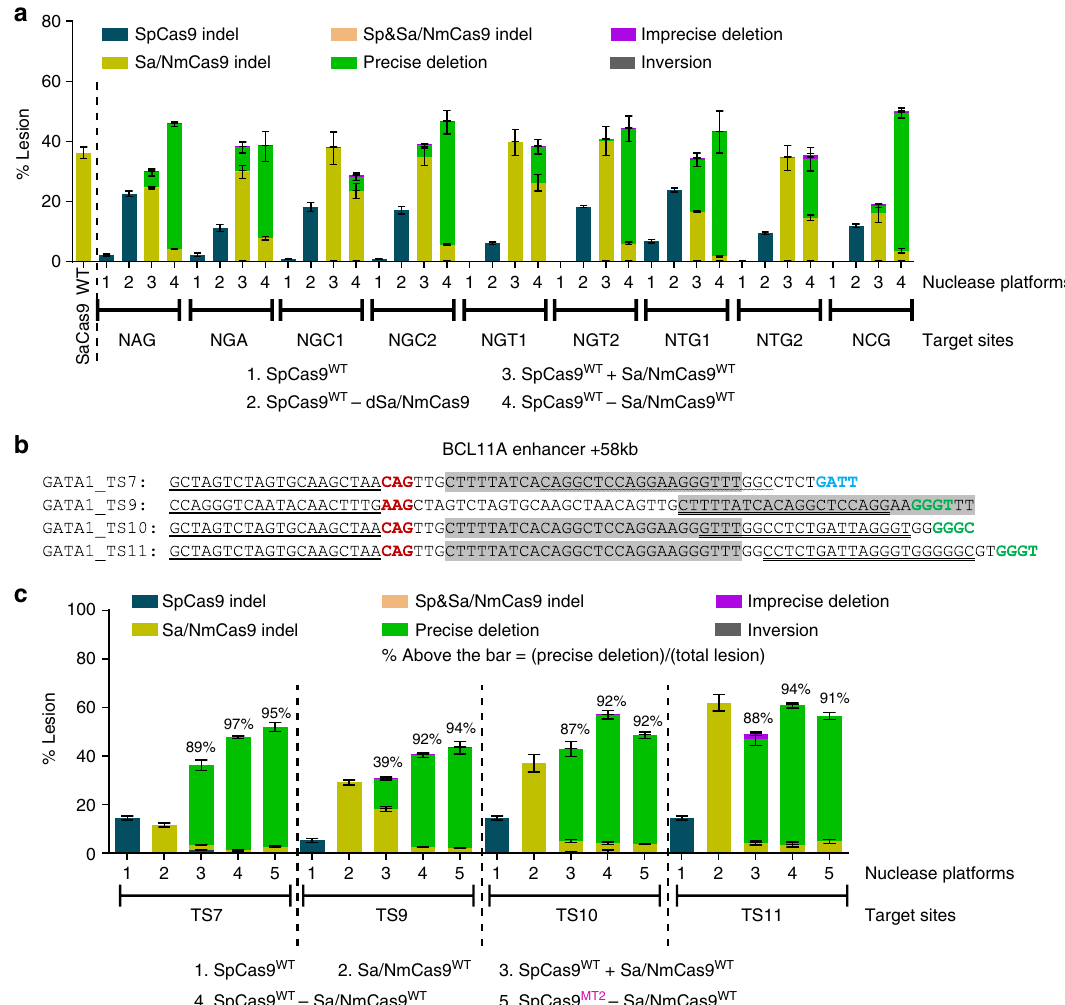
Fig. 5 Cas9 – Cas9 fusions expand the targeting range of SpCas9 allowing deletion of the GATA1-binding element in the BCL11A enhancer + 58kb. a Lesion rates and types at tandem target sites, with suboptimal SpCas9 but canonical SaCas9 PAMs (Supplementary Fig. 8) are determined by deep sequencing with bulk analysis. SaCas9 generates robust editing whereas SpCas9 displays low or no activity. In Cas9 – Cas9 fusion format, SpCas9 cuts effectively at these protospacers as observed from the SpCas9 – dSaCas9 fusions or the fused wild-type nucleases. b Sequence information of the four target sites chosen for more detailed assessment of the application of Cas9 – Cas9 fusions for the deletion of the GATA1-binding element in the functional core of the BCL11A enhancer + 58kb (highlighted in gray 21 ). c Lesion rates and types at four target sites spanning the GATA1 element are determined by deep sequencing after UMI-correction. Deep sequencing data are from three independent biological replicates performed on different days in HEK293T cells (Supplementary Data 1). Error